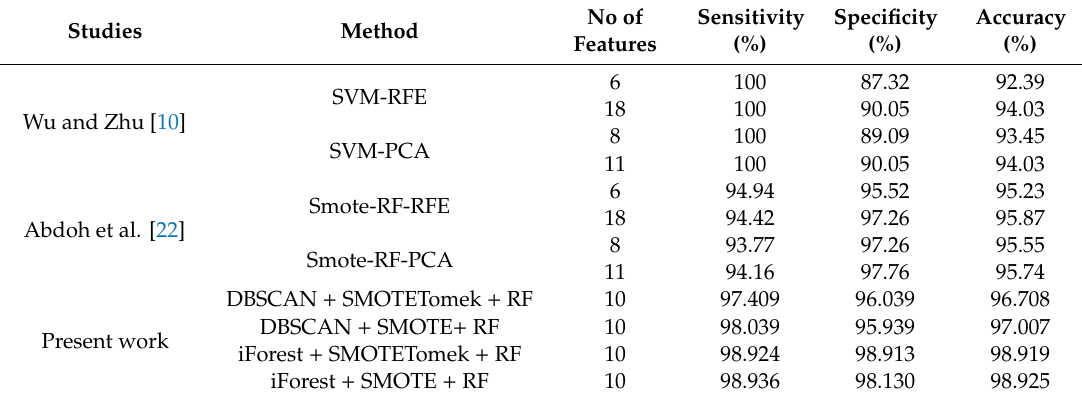
Table 22. Comparison of biopsy test results of CCPM with past